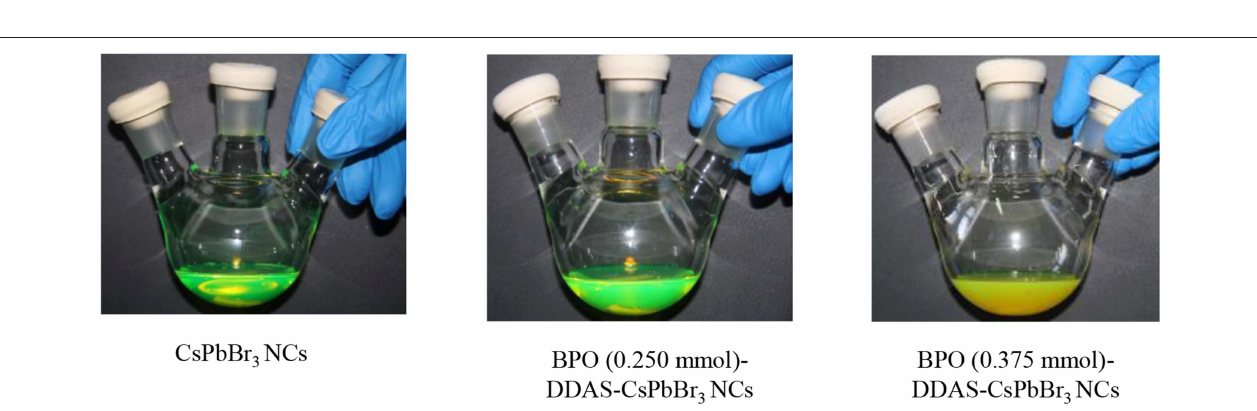
FIGURE 5 | Photographs of CsPbBr 3 NCs, BPO (0.250 mmol)-DDAS-CsPbBr 3 NCs, and BPO (0.375 mmol)-DDAS-CsPbBr 3 NCs.